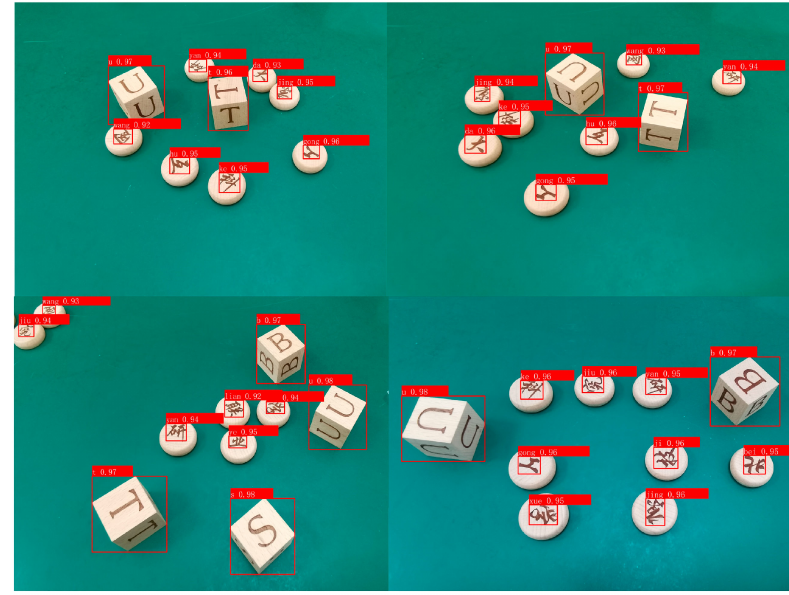
Figure 8. The illustration of Chinese character recognition